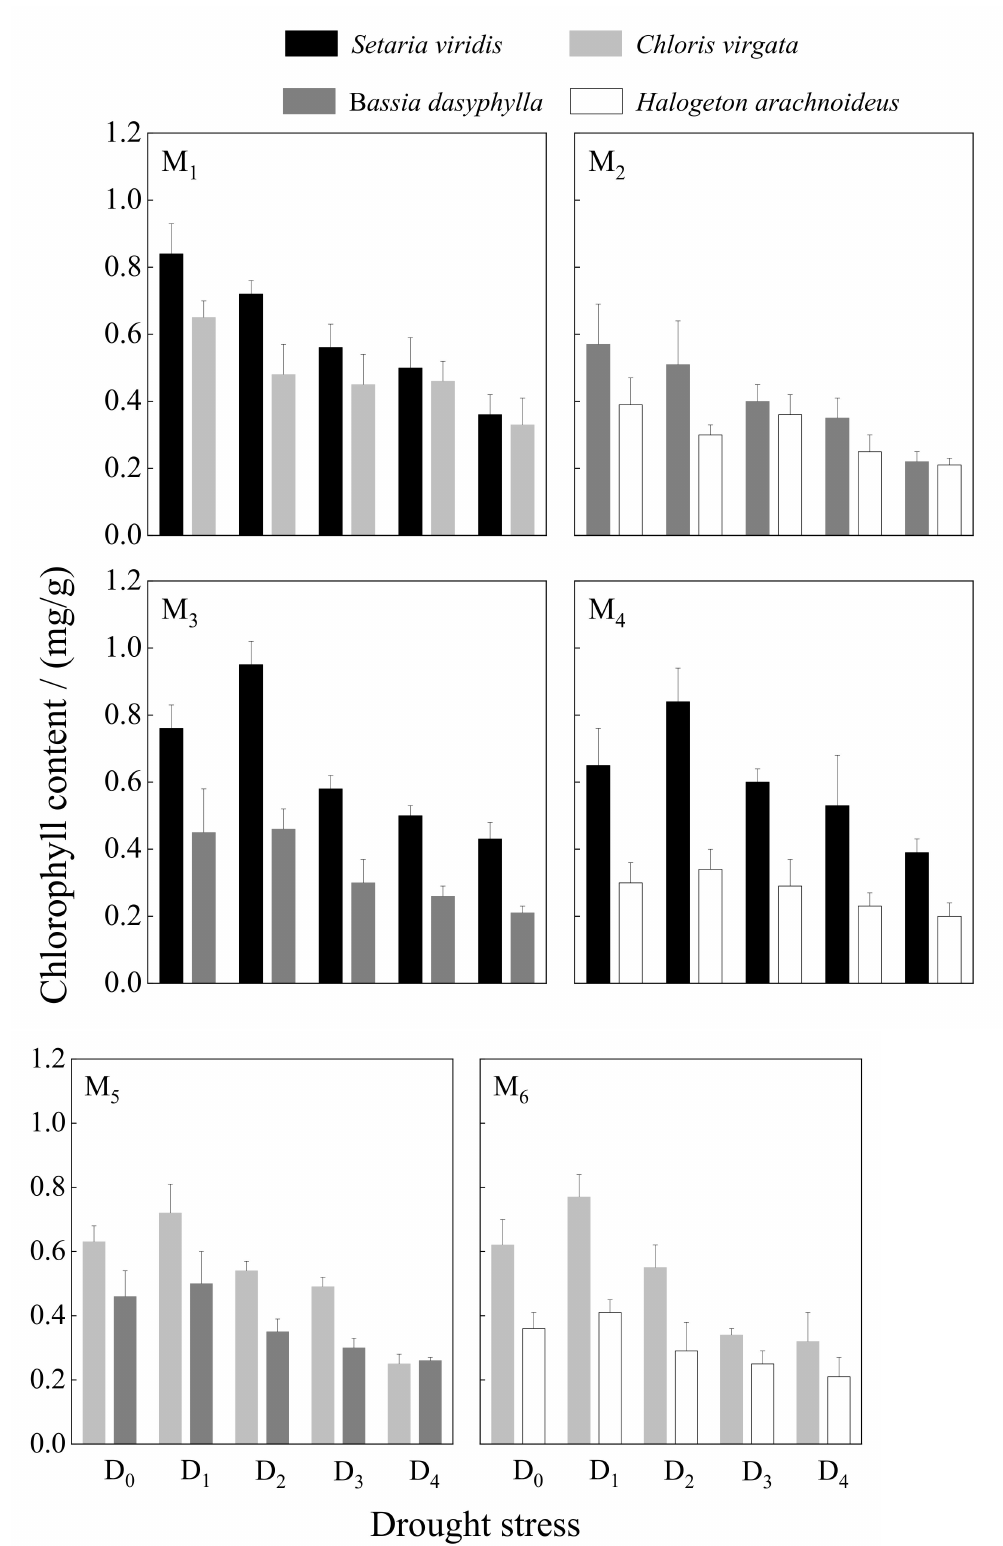
Figure 4. Response of chlorophyll content of four annual desert plants to the interaction of drought and mixed sowing (M1–M6 represents the mixed growth combination of different plants: Setaria viridis and Saxifragon (M1), Chenopodium glaucum and white stem halophyte (M2), Setaria viridis and white stem halophyte (M3), Setaria viridis and white stem halophyte (M4), Setaria viridis and white stem halophyte (M5), Setaria viridis and white stem halophyte